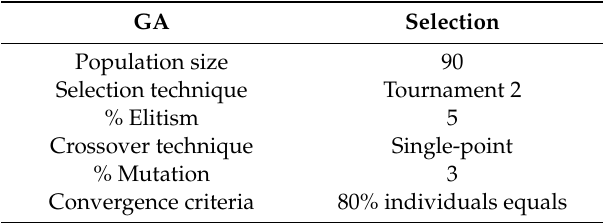
Table 2. Configuration of the principal elements of the Genetic Algorithm (GA).